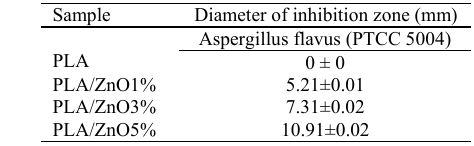
Fig. 2. Antifungal activity of nano ZnO 0, 1%, 3% and 5% (a, b, c and d) particles against Aspergillus parasiticus (PTCC 5286) Table 2. Diameter of inhibition zone (mm) in poly lactic acid films containing nano-zinc oxide on Aspergillus flavus (PTCC 5004)